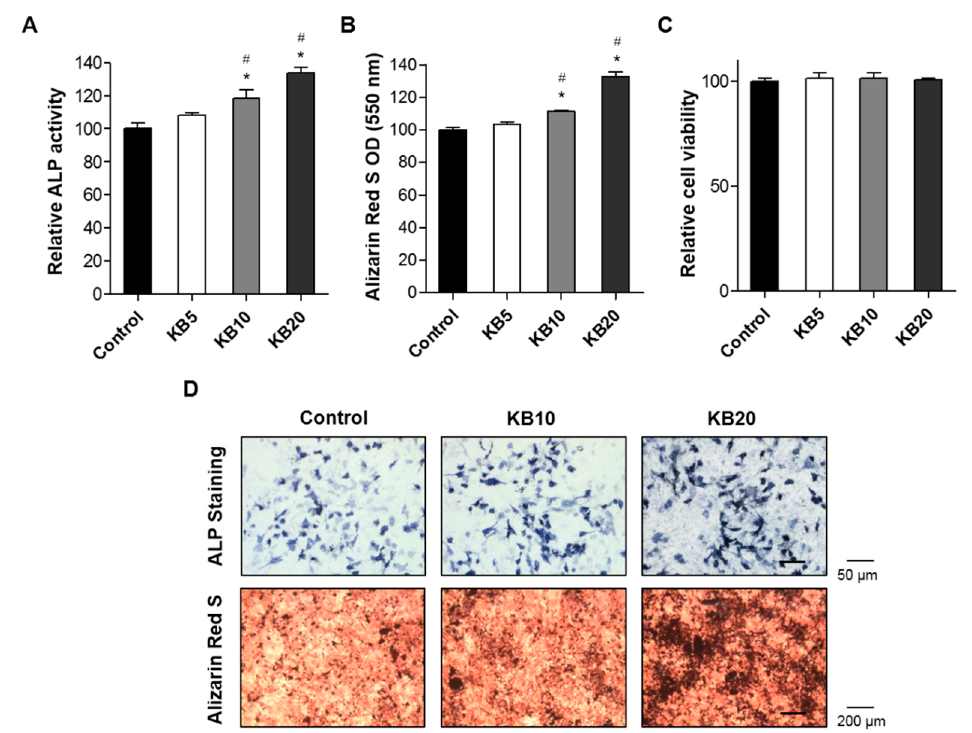
Figure 2. The effects of kukoamine B (KB) on cellular differentiation, cell viability, and mineralized nodule formation of the preosteoblast MC3T3-E1 cells. ( A , B ) Assessment of alkaline phosphatase (ALP) activity and alizarin red S optical density (OD) value (550 nm) in KB-treated MC3T3-E1 cells. After induction of osteoblast differentiation with 50 μ g/mL of ascorbic acid and 10 mM of β -glycerophosphate, cells were treated with three different KB concentrations (5, 10, and 20 μ M) for 3 and 21 days, respectively, and then ALP activity and alizarin Red S OD value were assessed. *: p < 0.05 vs. Control, # : p < 0.05 vs. KB5 (Tukey’s honest significant difference (HSD) post hoc test, ANOVA). ( C ) Assessment of the cell viability in the KB-treated MC3T3-E1 cells. Cells were treated with three different concentrations of KB (5, 10, and 20 μ M) for three days, and then cell viability was assessed. ( D ) Assessment of ALP staining and in vitro bone mineralization in the KB-treated MC3T3-E1 cells. After the induction of osteoblast differentiation, the cells were treated with 10 and 20 μ M of KB for three days (for ALP staining) or 21 days (for mineralized nodule formation staining), and then cells were stained with ALP and alizarin red S. The positively stained cells and nodules were visualized under a microscope. Control: KB non-treated cells.